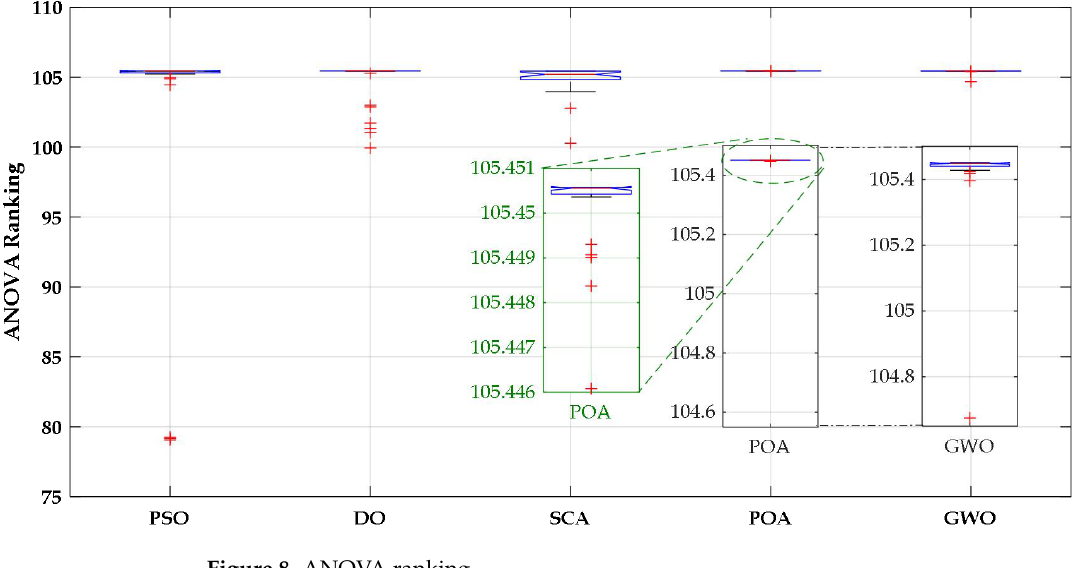
Figure 8. ANOVA ranking.